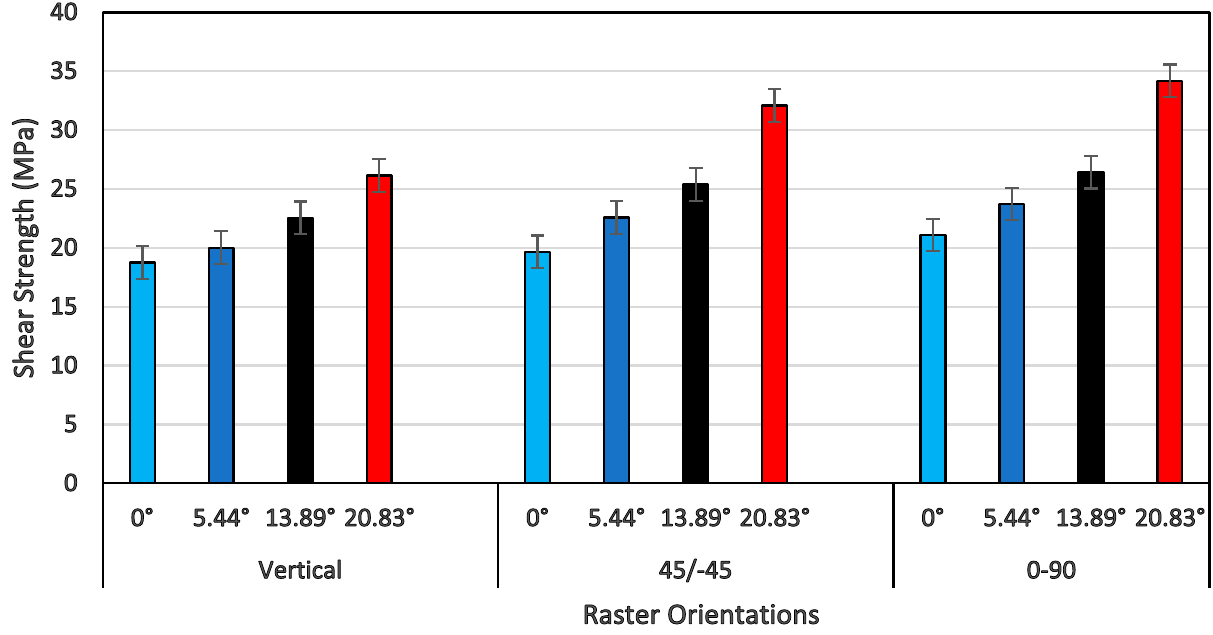
Figure 13. Shear strength with their respective raster orientations and shear angles.